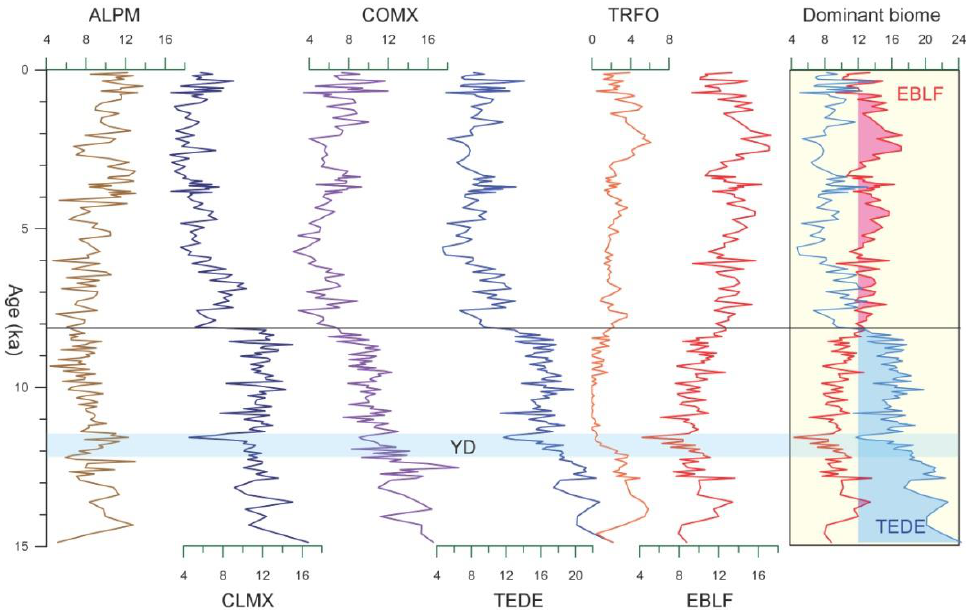
Figure 3. Reconstructed biomes of the last 15 ka BP derived from the pollen record SZY in southeastern China. The principal biomes shown are subtropical evergreen broadleaved forest (EBLF), tropical rain forest (TRFO), temperate deciduous broadleaved forest (TEDE), cold mixed forest (CLMX), cool mixed forest (COMX) and alpine shrub and meadow (ALPM).